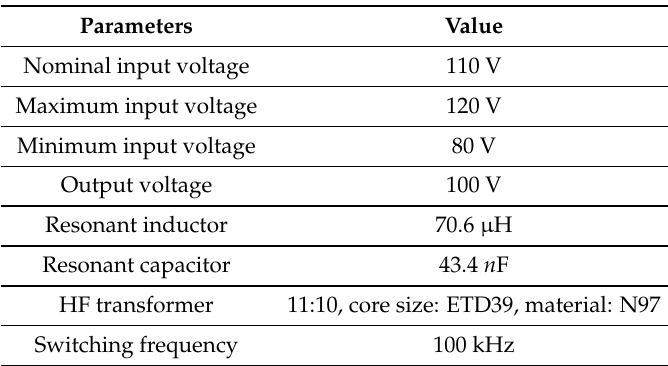
Table 2. The specifications of the